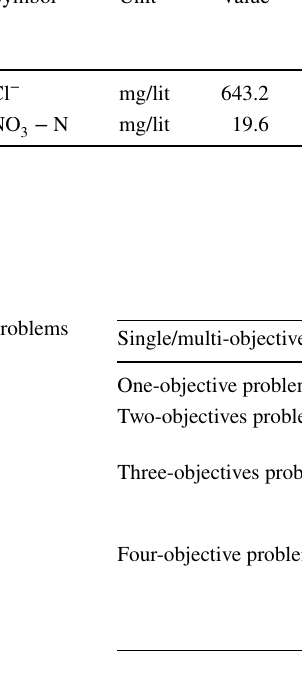
Fig. 3 Location map of the study area Table 2 Contaminant Values and Standard Values in Iran Contaminant